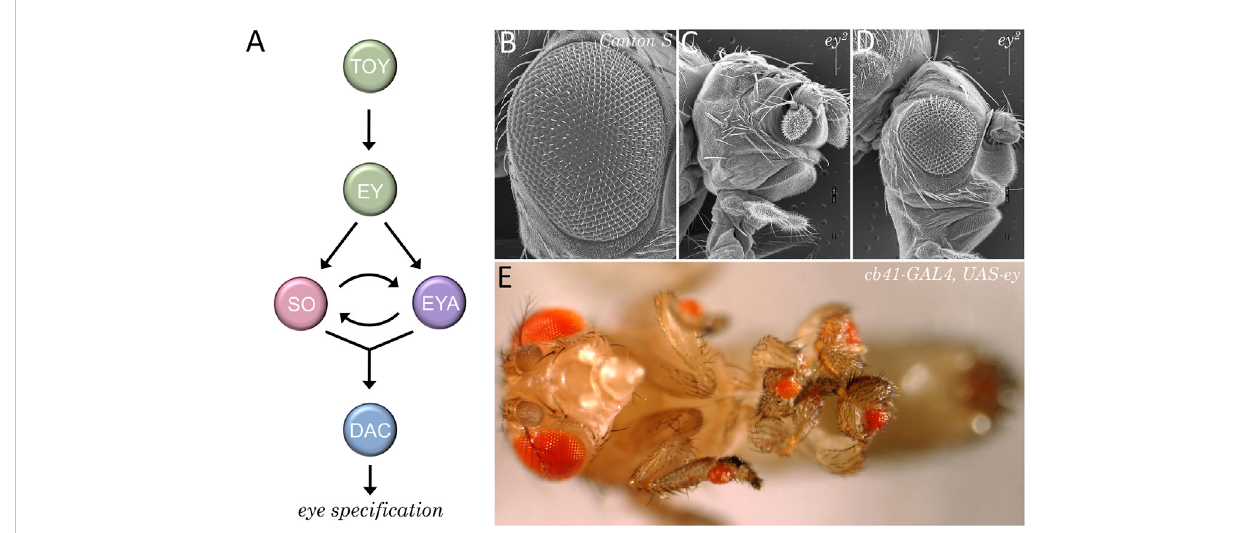
FIGURE 10 Theretinal determination networkspeci fi esthefateoftheeye. (A) Thecoremembersoftheretinal determination network include thetranscription factorsEyeless(Ey),TwinofEyeless(Toy),SineOculis(So),EyesAbsent(Eya),andDachshund(Dac). (B – D) Scanning electronmicrographsofwildtype (B) and eyeless loss-of-function mutants (C, D) . Disruptions to the retinal determination network result in either the loss or the severe reduction of the compound eye. (E) Forced expression of members of the retinal determination network can induce the transdetermination of non-ocular tissues such as legs, wings, halteres, antennae, and genitalia into